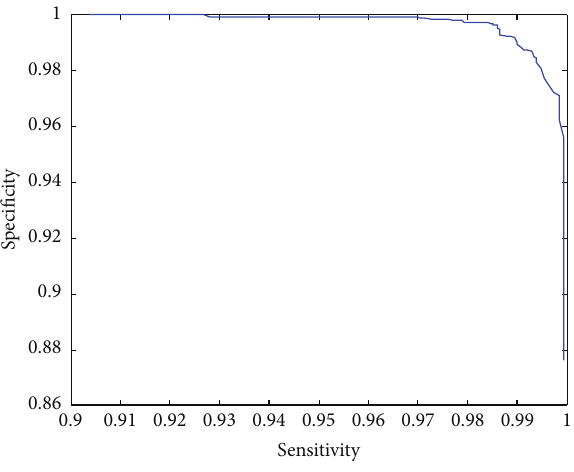
Figure 1: Plot of 4000 expression profiles for evaluating significance analysis method.